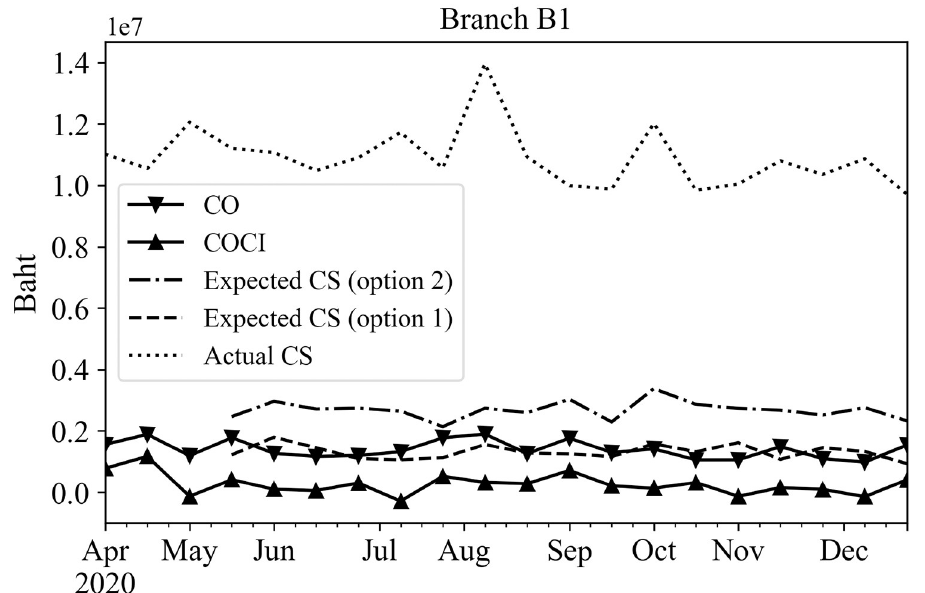
Fig 11. Expected and actual cash stocks, CO, and COCI of an example branch that opens Monday—Saturday.